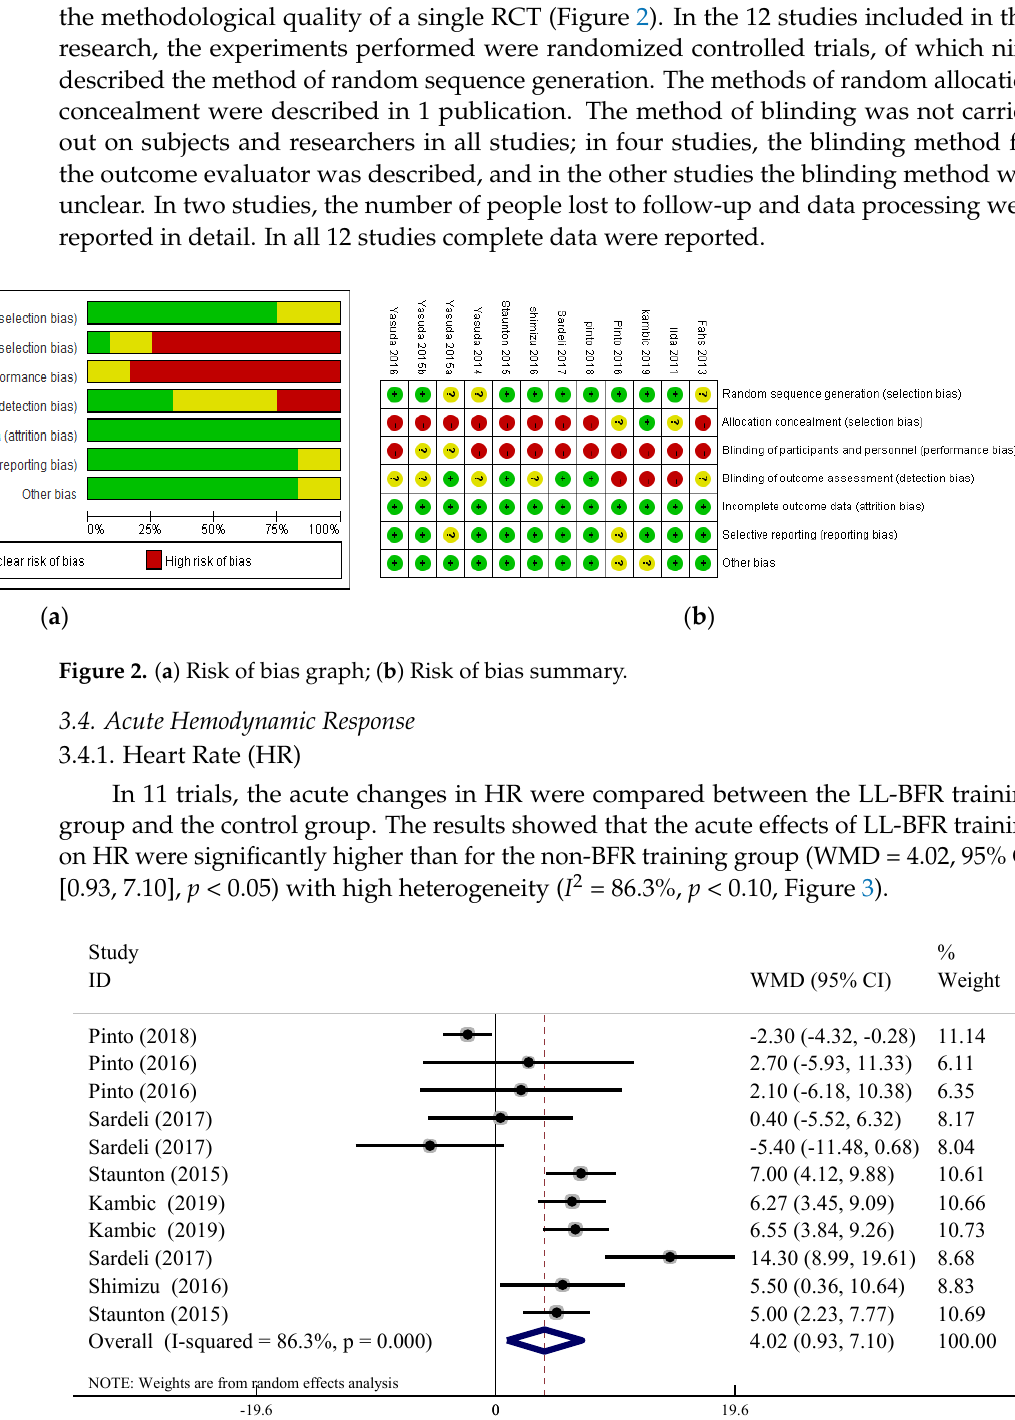
Figure 3. Acute effect of BFR-LI training on heart rate.